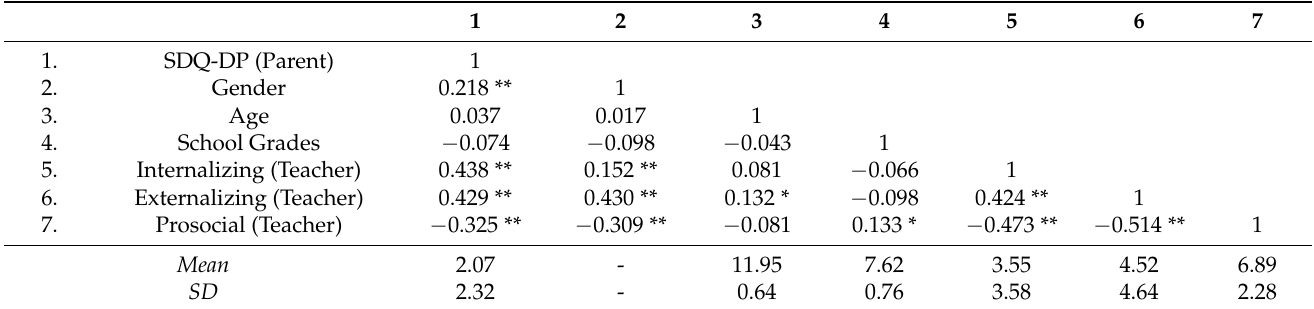
Table 1. Zero-order